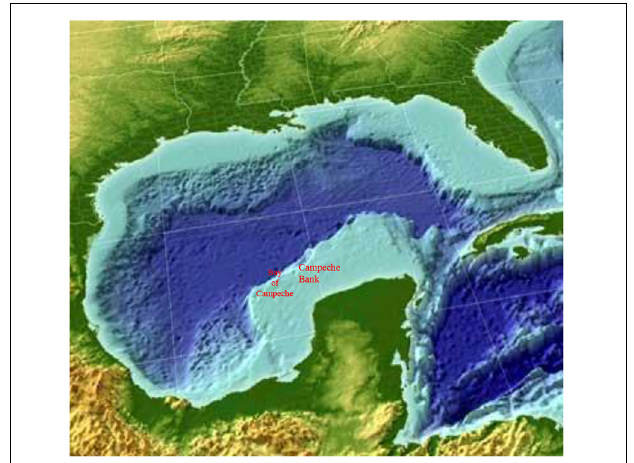
FIGURE 1 | Location of the Bay and Campeche Bank in the southwestern Gulf of Mexico (modified from Google